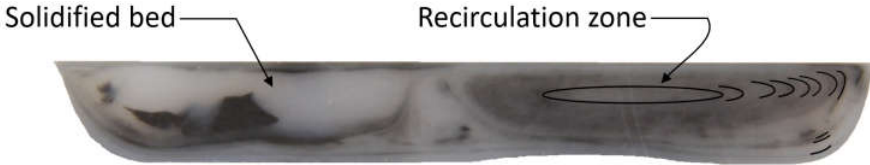
Figure 7. Cross‐section of general purpose screw channel at turn 21; the solids bed and recirculation zone having at least eleven recirculations are evident with a poorly worked black pellet in the solids bed.